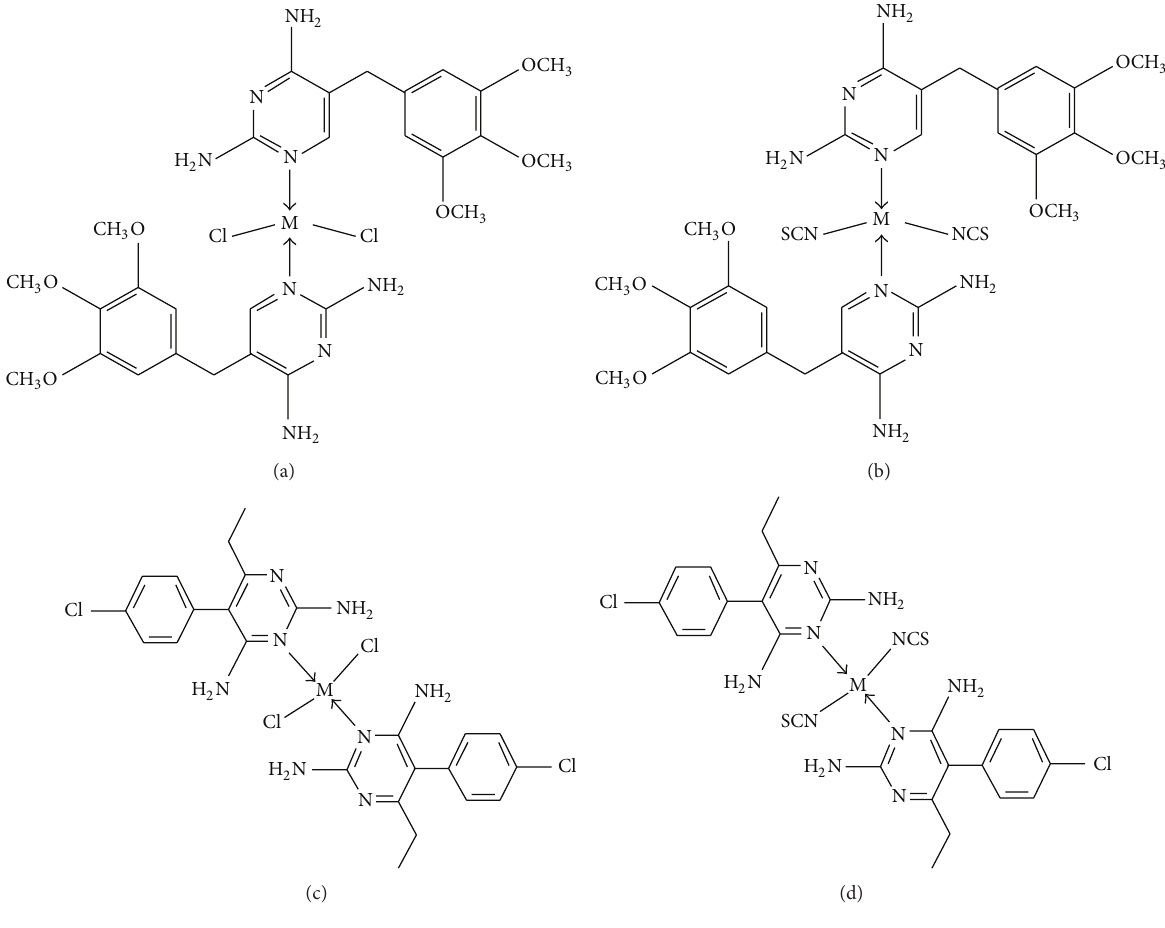
Figure 1: Proposed structures for the metal